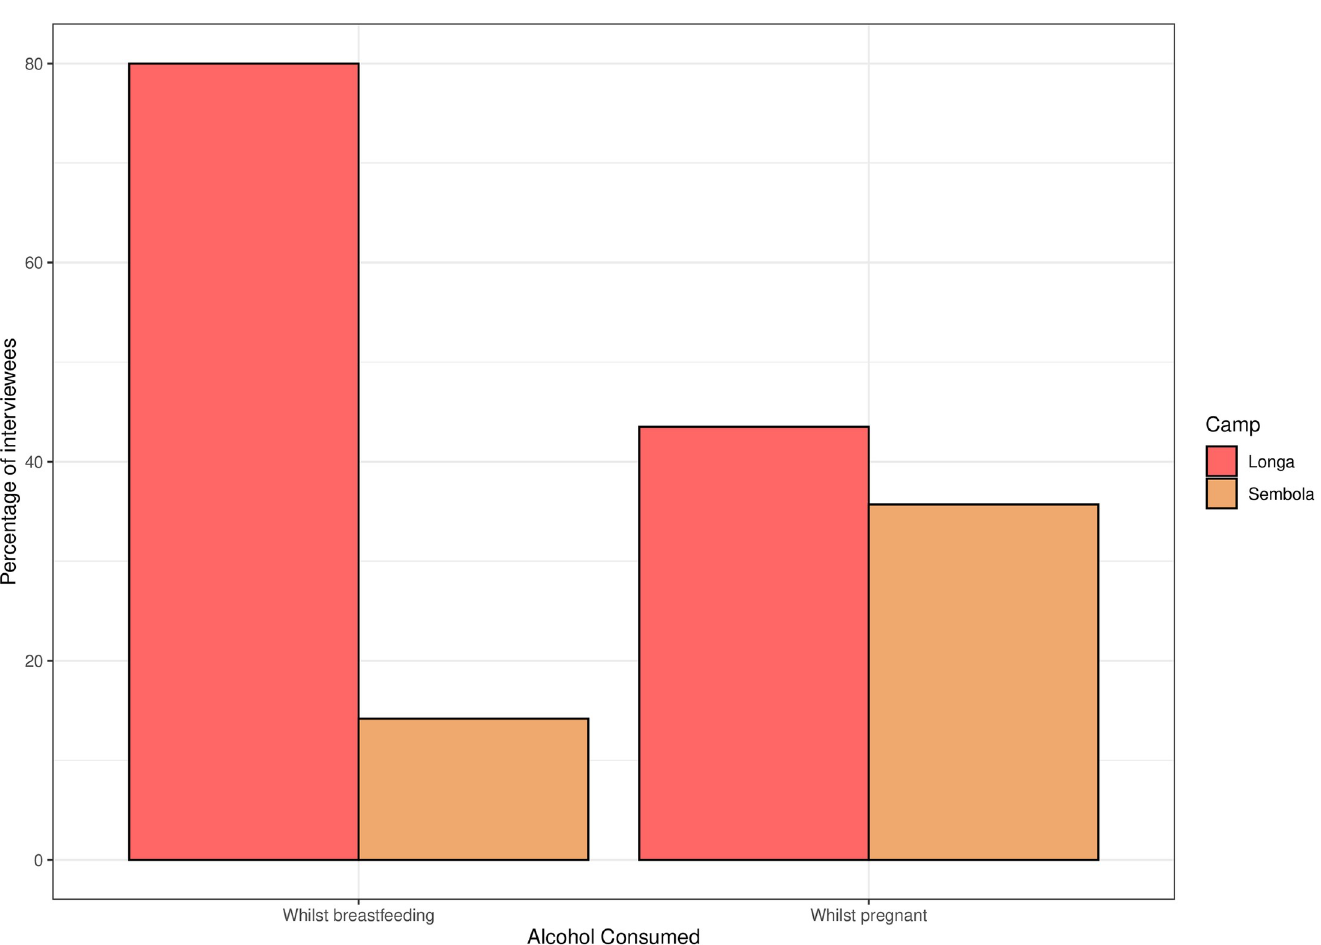
Fig 3. Percentage of participants reporting that they or their partner consumed alcohol while pregnant or breastfeeding, separated by camp.